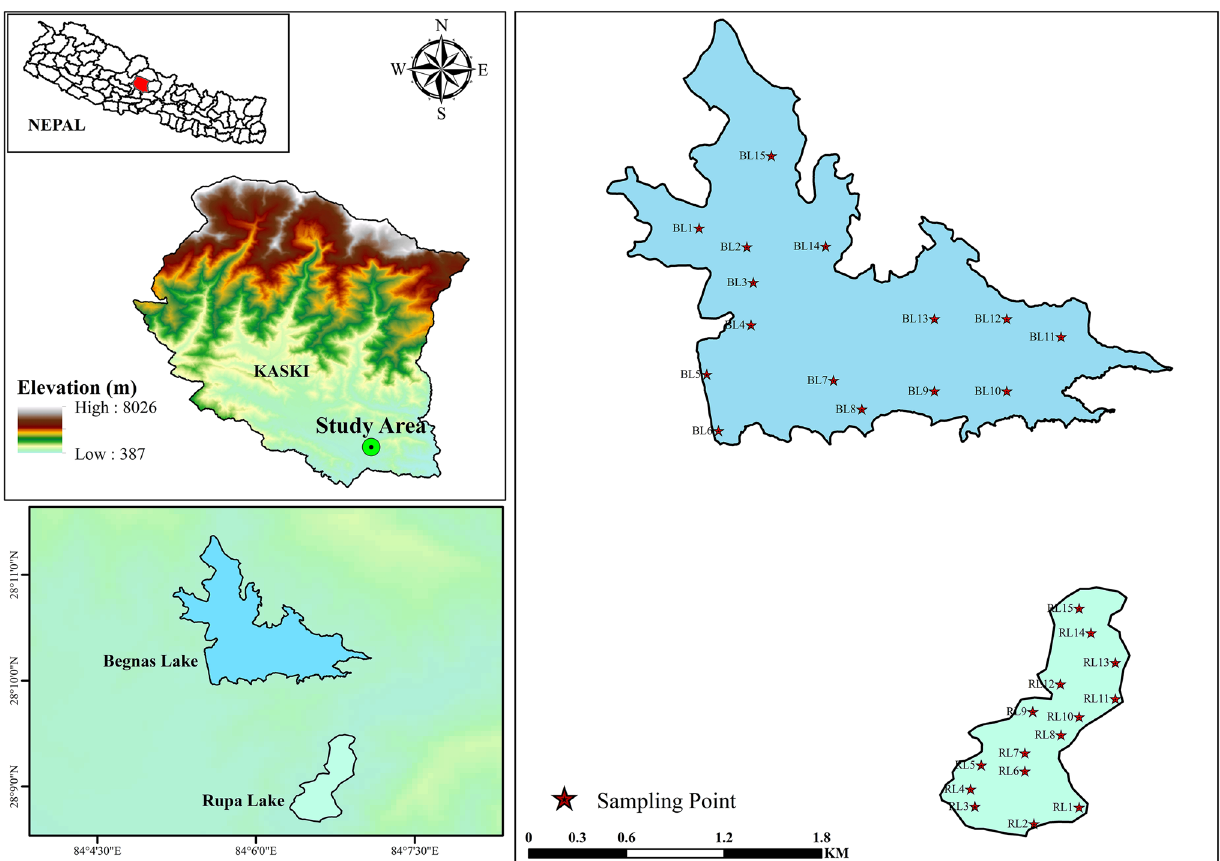
Fig. 1 Sampling points in the Begnas Lake and Rupa Lake, Gandaki Province,